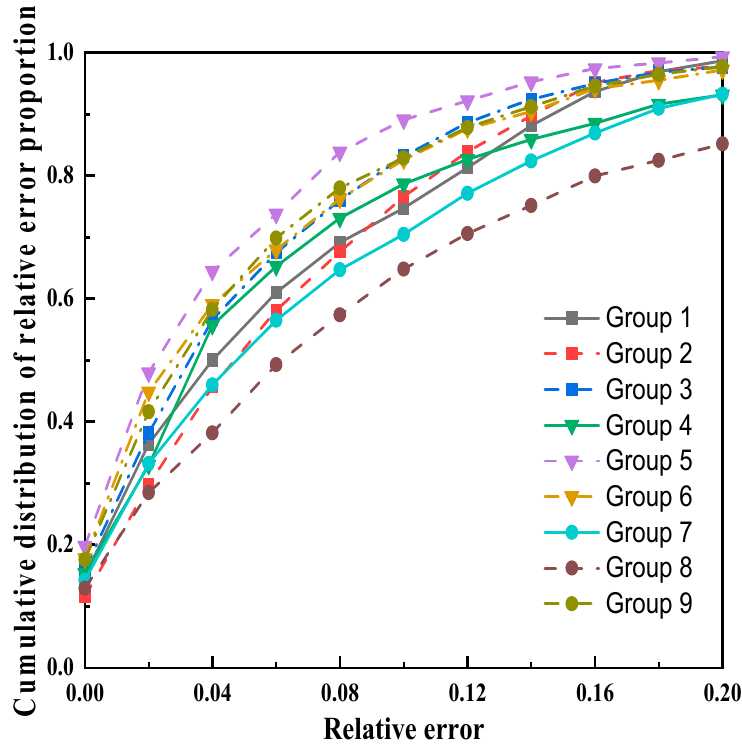
Figure 11. The cumulative distribution of relative error proportions for each group. Table 1. The summary of the three subjects.